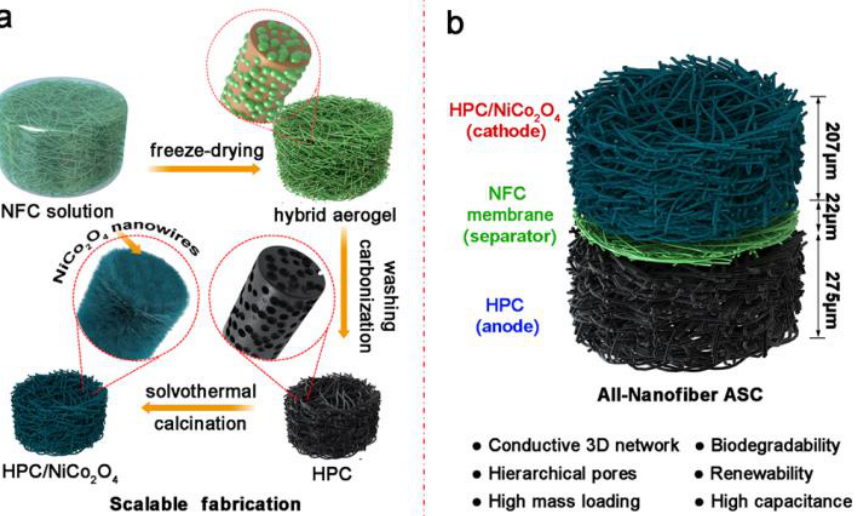
Figure 6. Schematic representation of the ( a ) fabrication of nanocellulose-derived HPC and HPC/NiCo 2 O 4 composite aerogels and ( b ) their asymmetric assembly into an all-nanofibre ASC device. Reprinted with permission from ref. [112]. 2019 American Chemical Society.